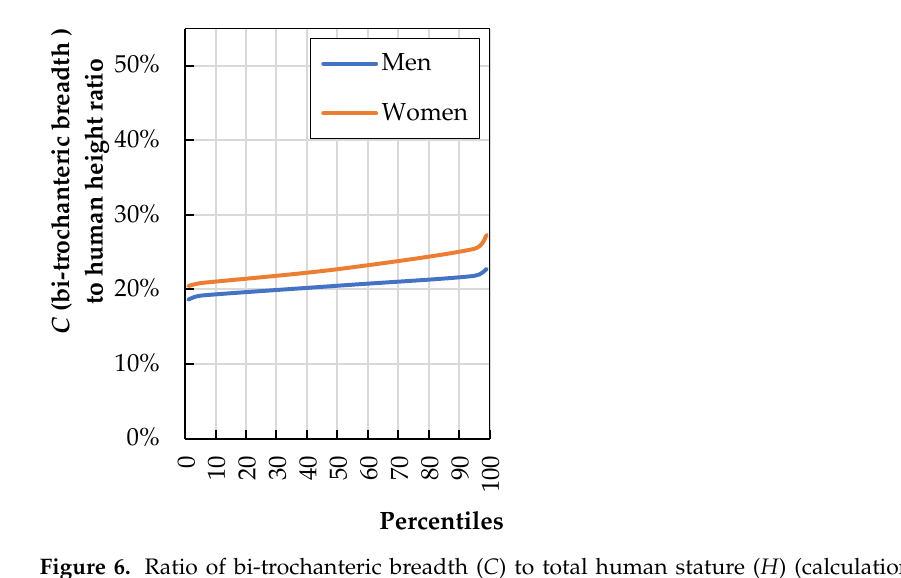
Figure 6. Ratio of bi-trochanteric breadth ( C ) to total human stature ( H ) (calculations based on literature data [20]).